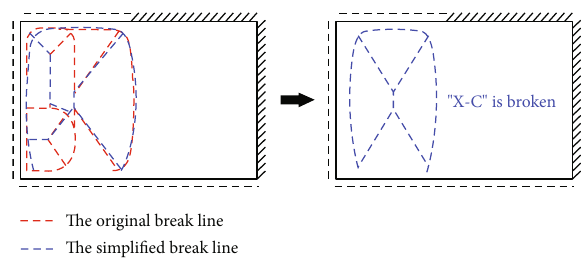
Figure 20: “ X-C-shaped ” fracture in full-scale mining stope.